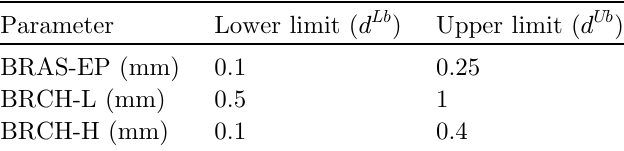
Table 4. Upper and lower limits of optimization variables.